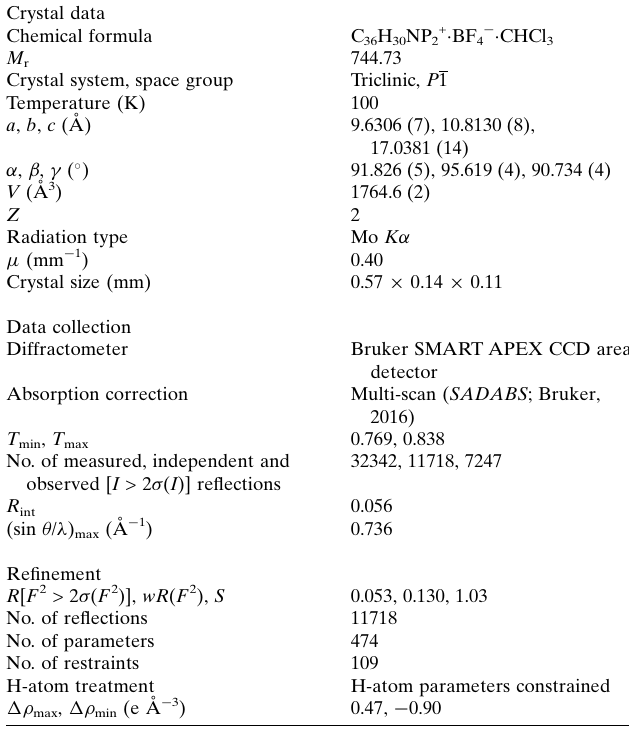
Table 2 Experimental details. Crystal data Chemical formula